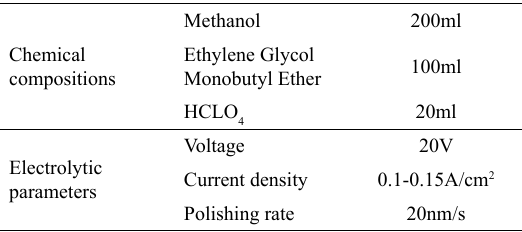
Figure 2. The experimental set-up Table 3. Parameters of the electro-polishing method